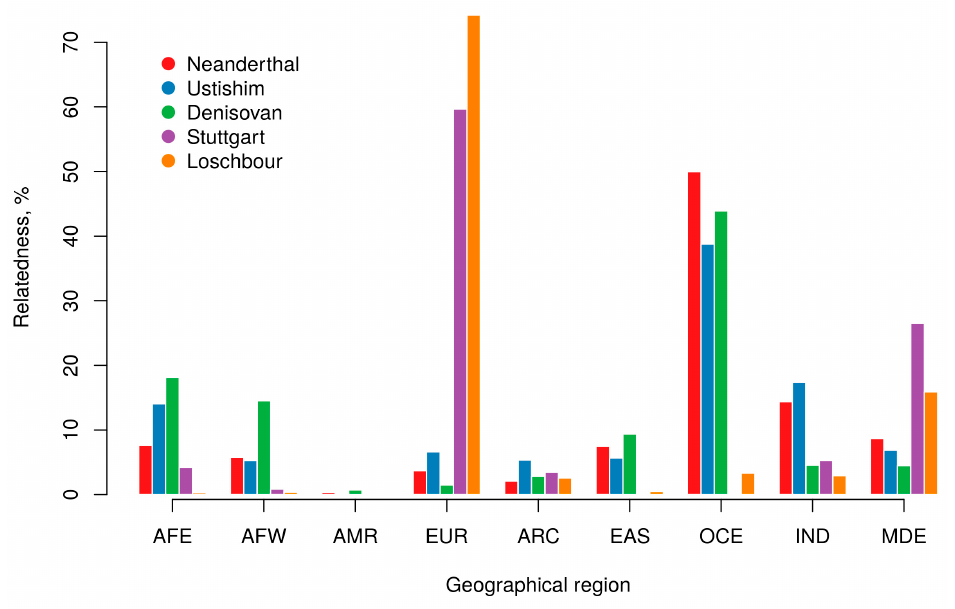
Figure 3. Relative abundance (in percentages) of IBD fragments from prehistoric people in modern people from major geographic regions.